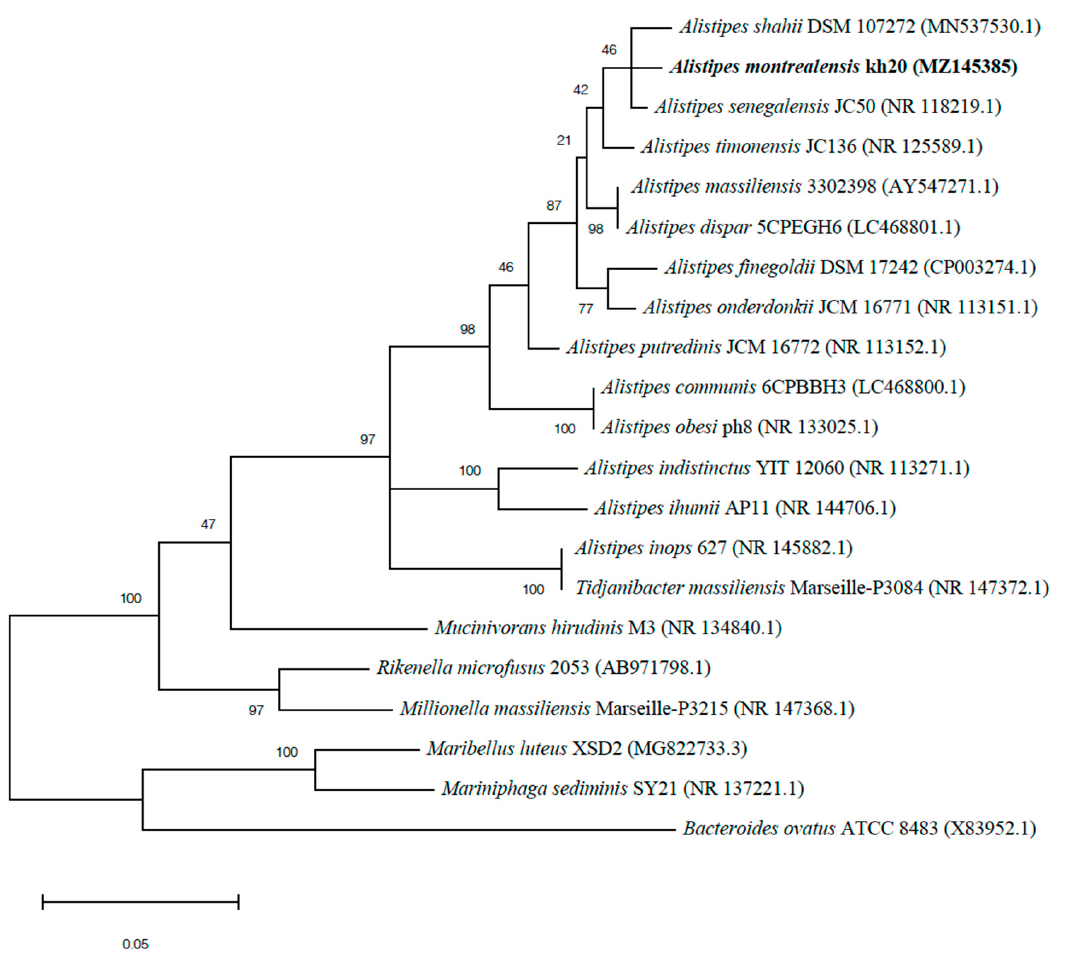
Figure 1. Phylogenetic tree highlighting the position of Alistipes montrealensis strain kh20 T relative to other closely related strains. GenBank accession numbers for each 16S rRNA are noted in parenthesis. Sequences were aligned using Muscle v3.8.31 with default parameters and phylogenetic inferences were obtained using the neighbor joining method with 500 bootstrap replicates, using MEGAX software. The scale bar represents a 5% nucleotide sequence